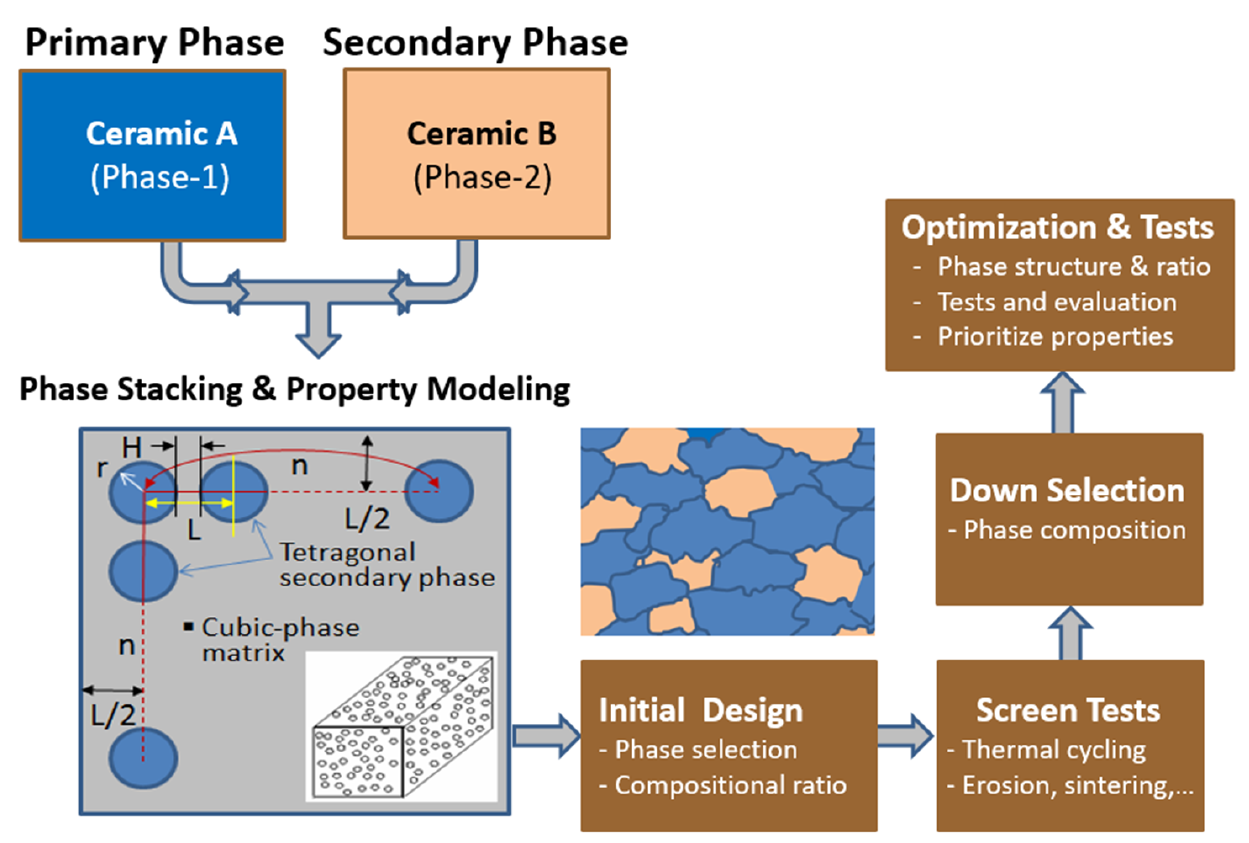
Figure 2. Flowchart for the concept and the design of an example two-phase composite ceramic and the sequential steps for developing and optimizing the topcoat in a TBC system.